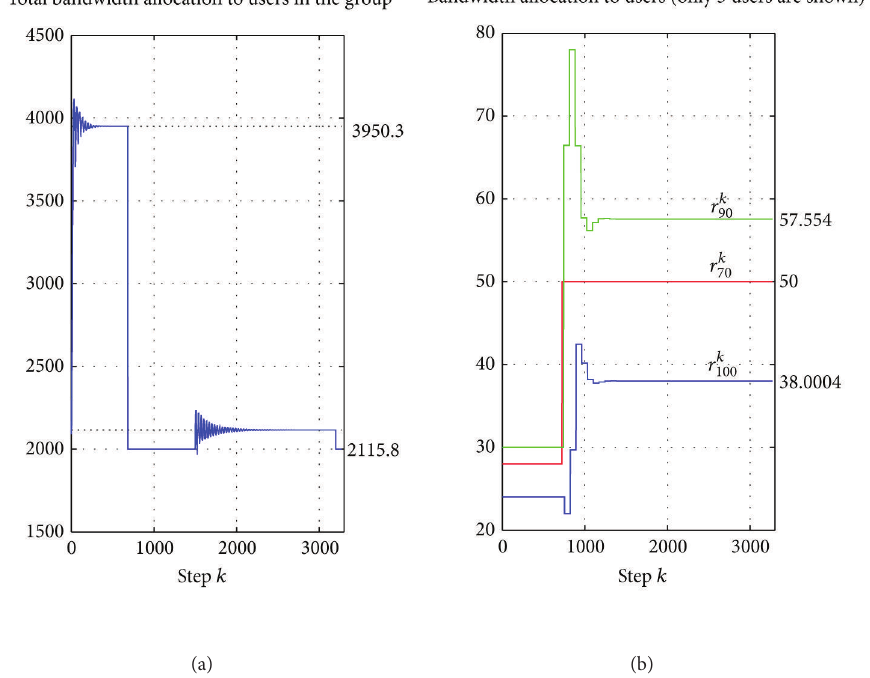
Figure 2: The sequence generated by Algorithm 1 for the